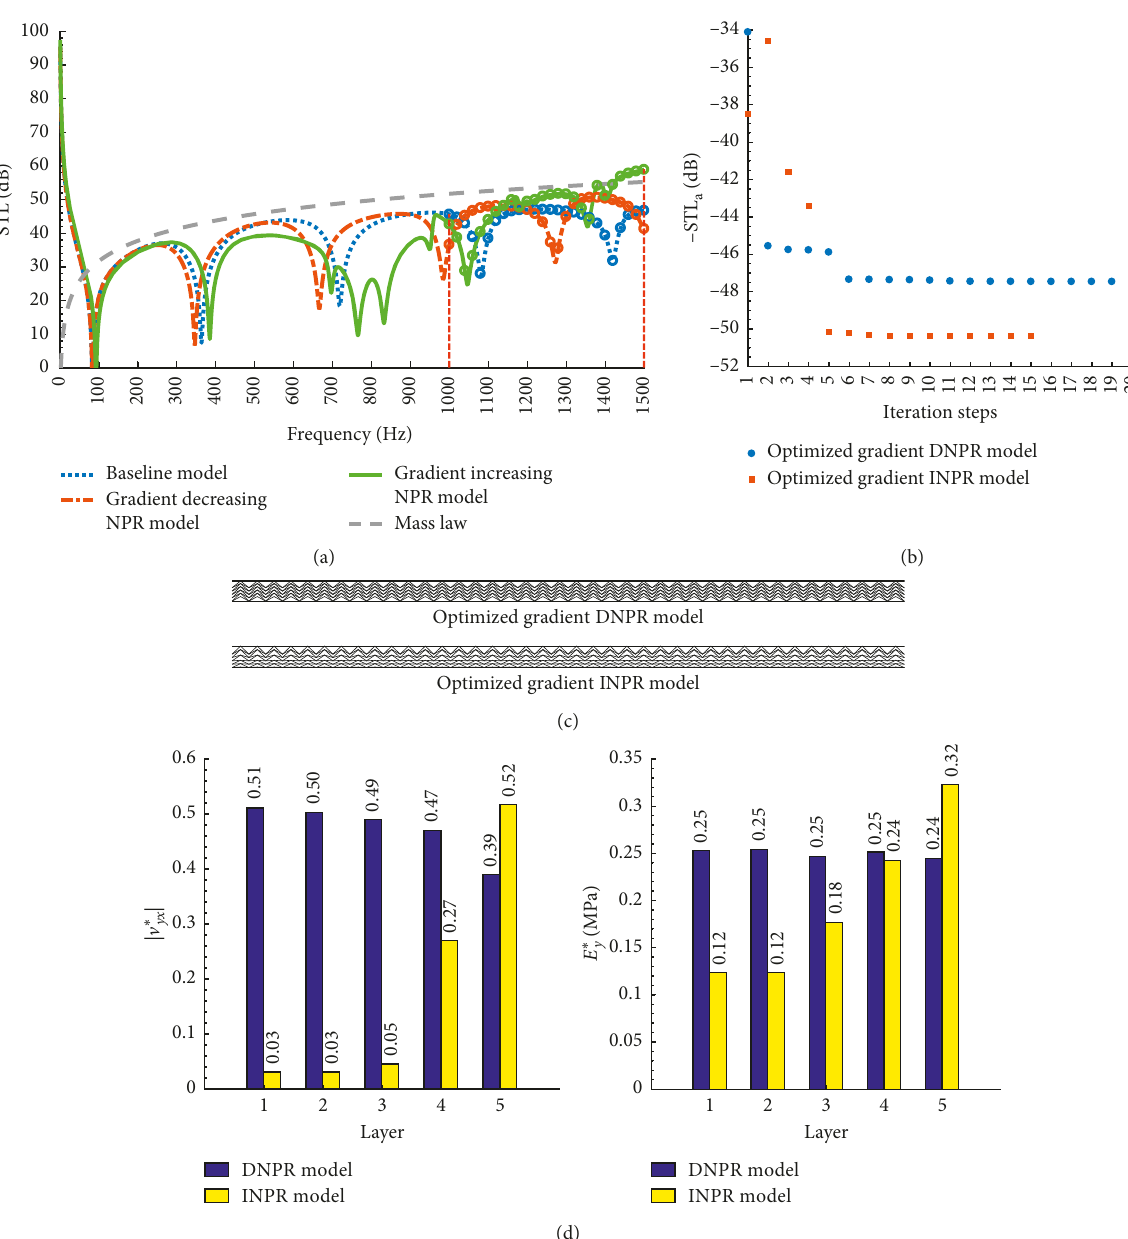
Figure 16: Optimal design from 1000 to 1500Hz: (a) STLs of the baseline and optimized models; (b) iteration steps; (c) configurations of the optimized gradient NPR models; (d) mechanical properties of the DAHs within the optimized gradient NPR models. Table 3: Characteristic parameters of the baseline and optimized models for optimal design from 1000 to 1500Hz.